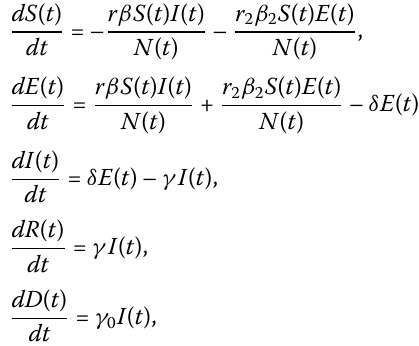
Figure 1 The transmission mechanism of